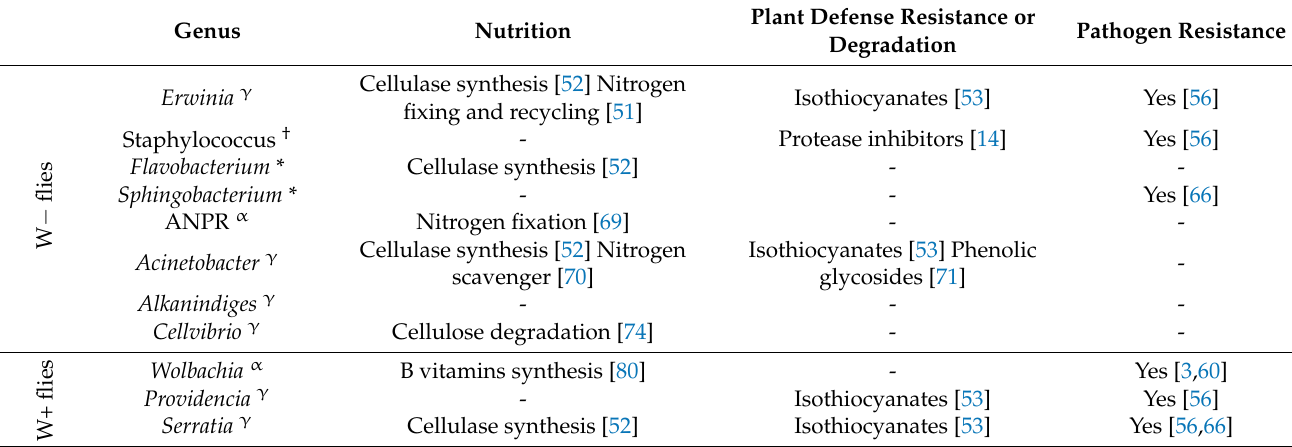
Table 1. Potential functional redundancy between bacteria of Wolbachia -free (“W − ”) and infected (“W+”) flies.